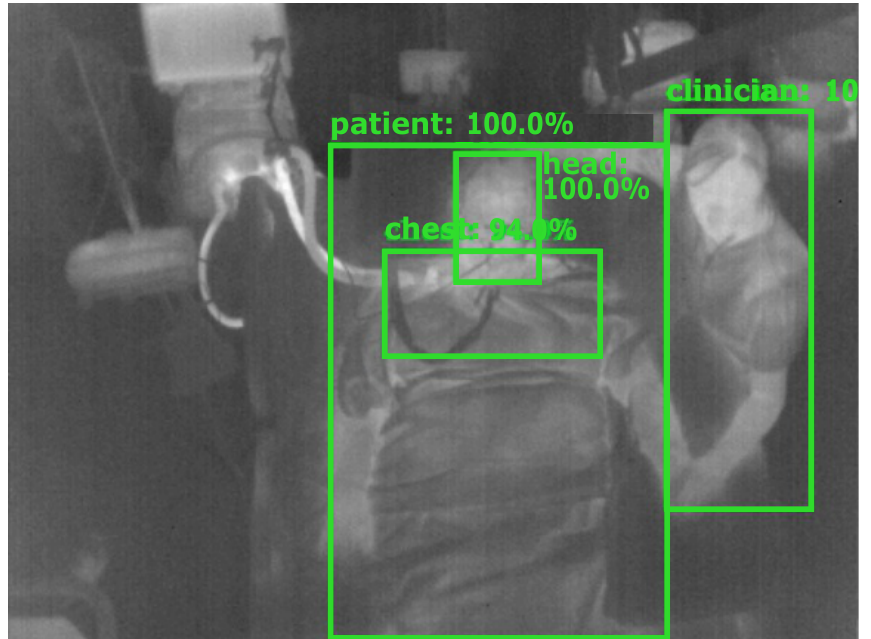
Figure 4. Detection result of